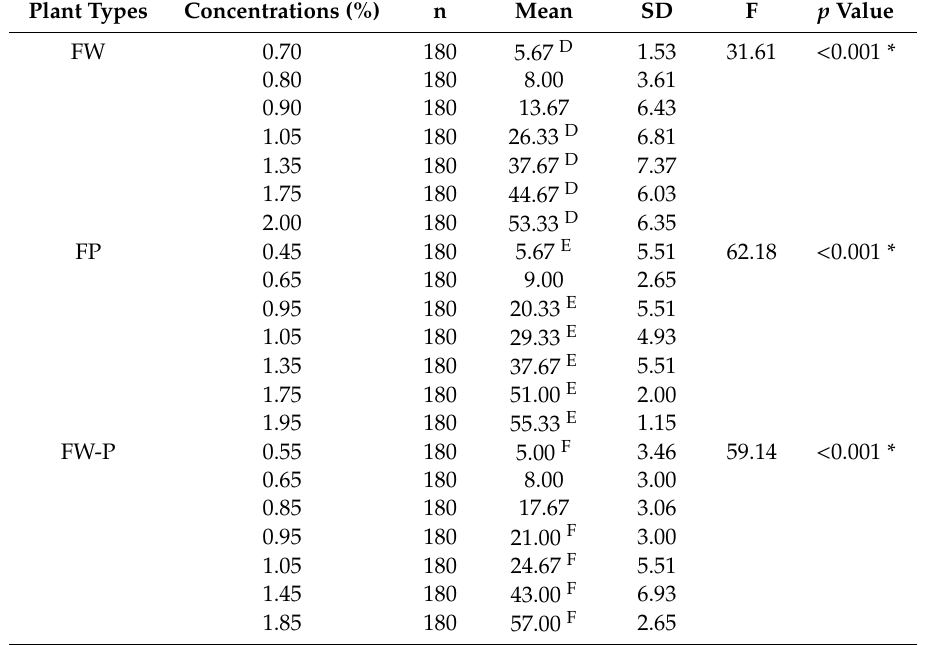
Table 3. Mean mortality rate of adulticidal activity of essential oils extracted from flower parts of A. conyzoides with three colours against adult Ae. aegypti females.